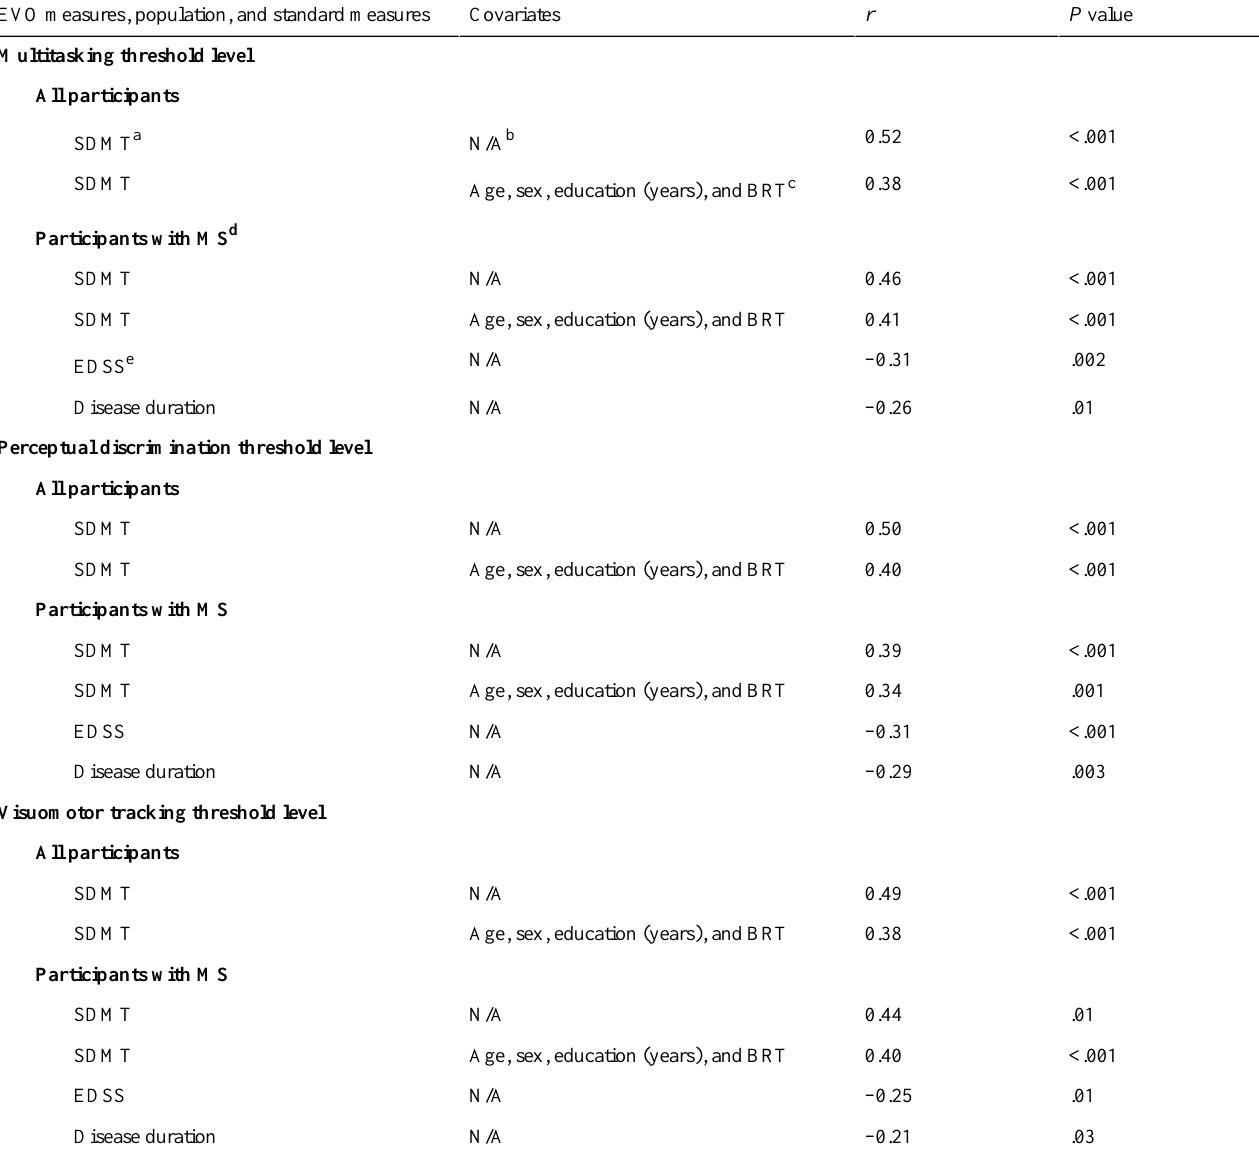
Table 2. Correlation between performance in standard cognitive measures and EVO Monitor.